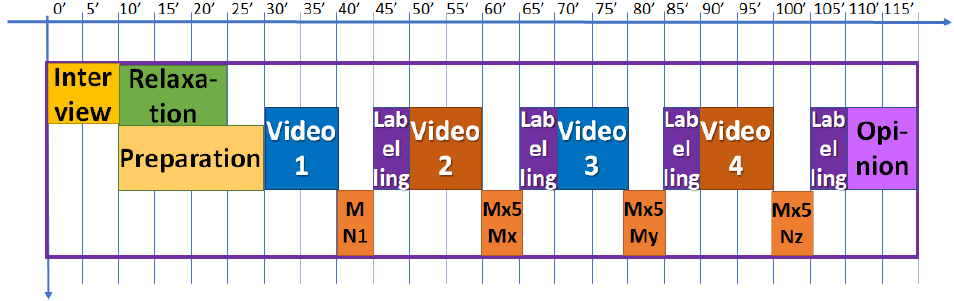
sample was taken. After videos 2, 3 and 4, five samples were collected, separated 1 min Figure 3. Schedule of the experiment for each volunteer. Figure 3. Schedule of the experiment for each volunteer. each, to monitor the changes in catecholamine levels, (Figure 5).